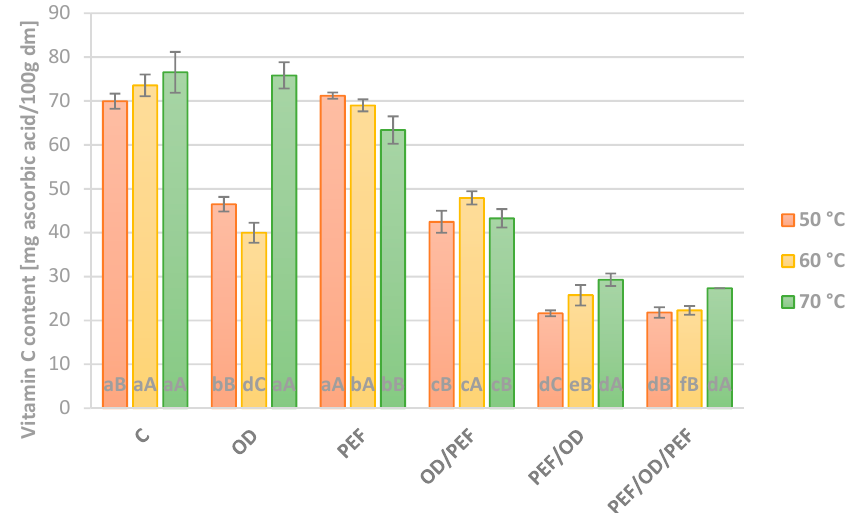
Figure 2. Vitamin C content of untreated and di ff erently pre-treated kiwifruit snacks dried at the temperatures of 50, 60 and 70 ◦ C. Di ff erent lowercase letters indicate significant di ff erences ( p < 0.05) between all considered samples at each drying temperature, while capital letters indicate significant di ff erences ( p < 0.05) between each sample at the three drying temperatures